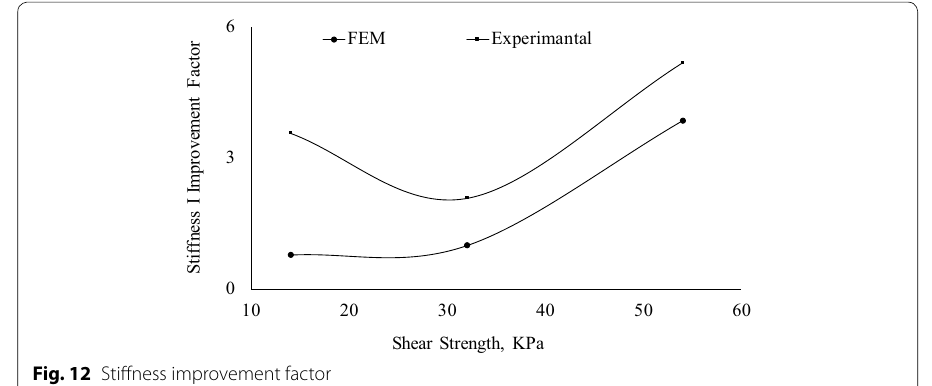
to 3 times the diameter of the column. Because of bulging, the lateral stresses on cohe- sive soil increases resulting in providing the additional confinement to the column. As a result, a balance condition occurs and vertical displacement decreases as compared to untreated soil. Figure 14 shows the bulging of the sand column. The bulging of the sand column is observed at the upper portion of the column and gradually increasing up to the depth of 1.5 to 2 times the diameter of the sand column. The maximum bulg- ing occurs at the upper portion of the column where axial load is maximum and with depth, the bulging decreases due to less effect of stress on the column. It is also noted that the bulging effect becomes zero at full depth of the column. Figure 15 present the typical relationship of settlement and axial capacity of the sand column at different shear